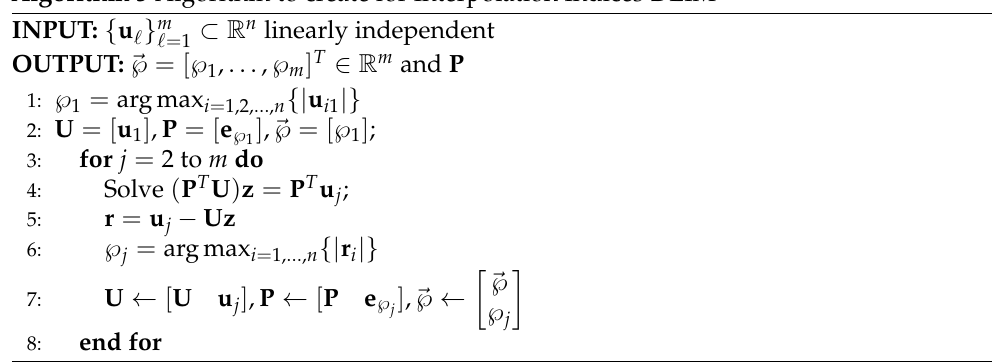
Algorithm 3 Algorithm to create for Interpolation Indices